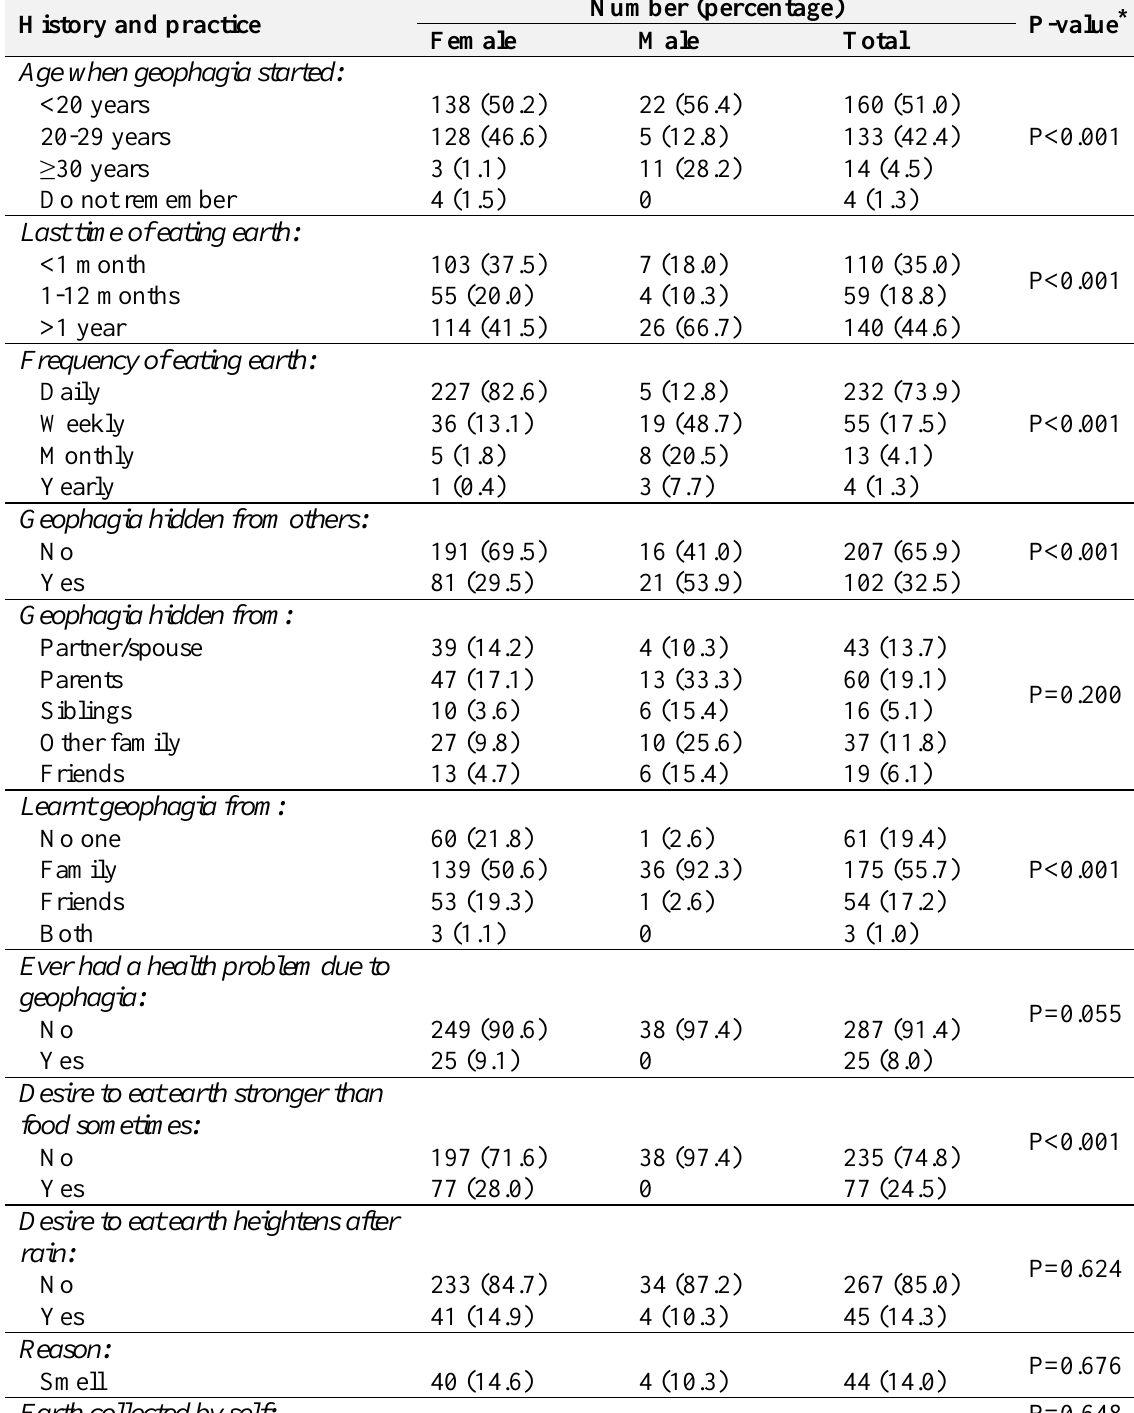
Number (percentage)